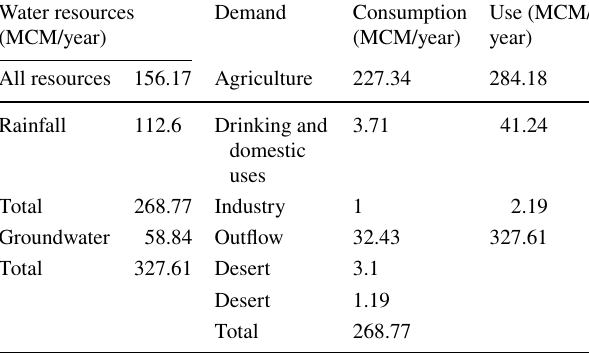
Table 4 The water balance for North Sinai Governorate (Al-Zayed